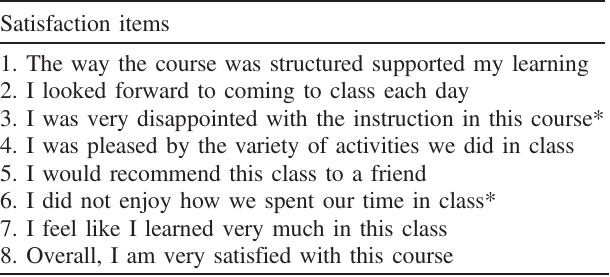
TABLE I. Items in the course satisfaction measure, on the week 14 survey. Starred items are reverse coded. Satisfaction